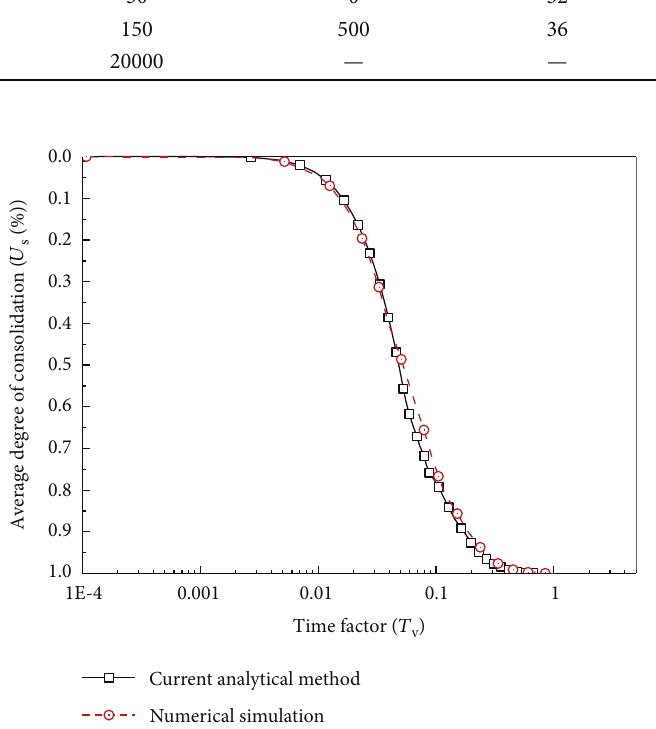
Figure 6: Comparison of the current analytical solution and numerical analysis.